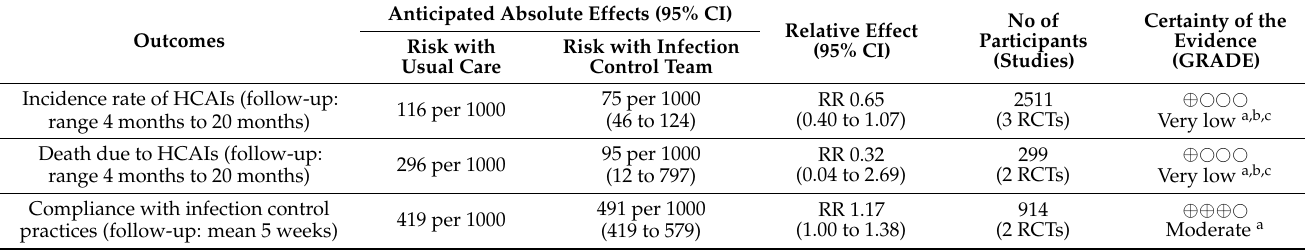
Table 2. Summary of findings and GRADE evidence profile.